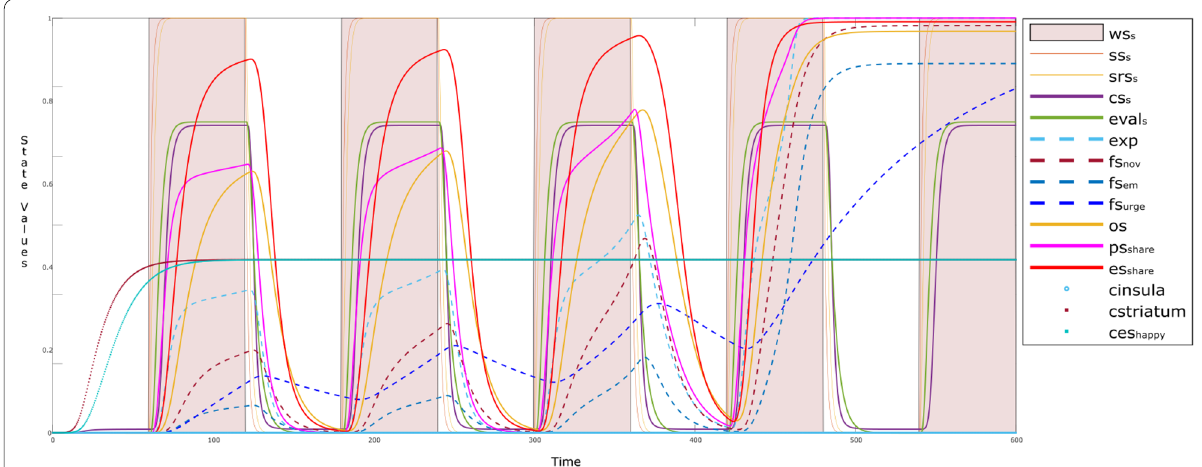
Fig. 7 W-states during the alternative episodes addressed in Fig.